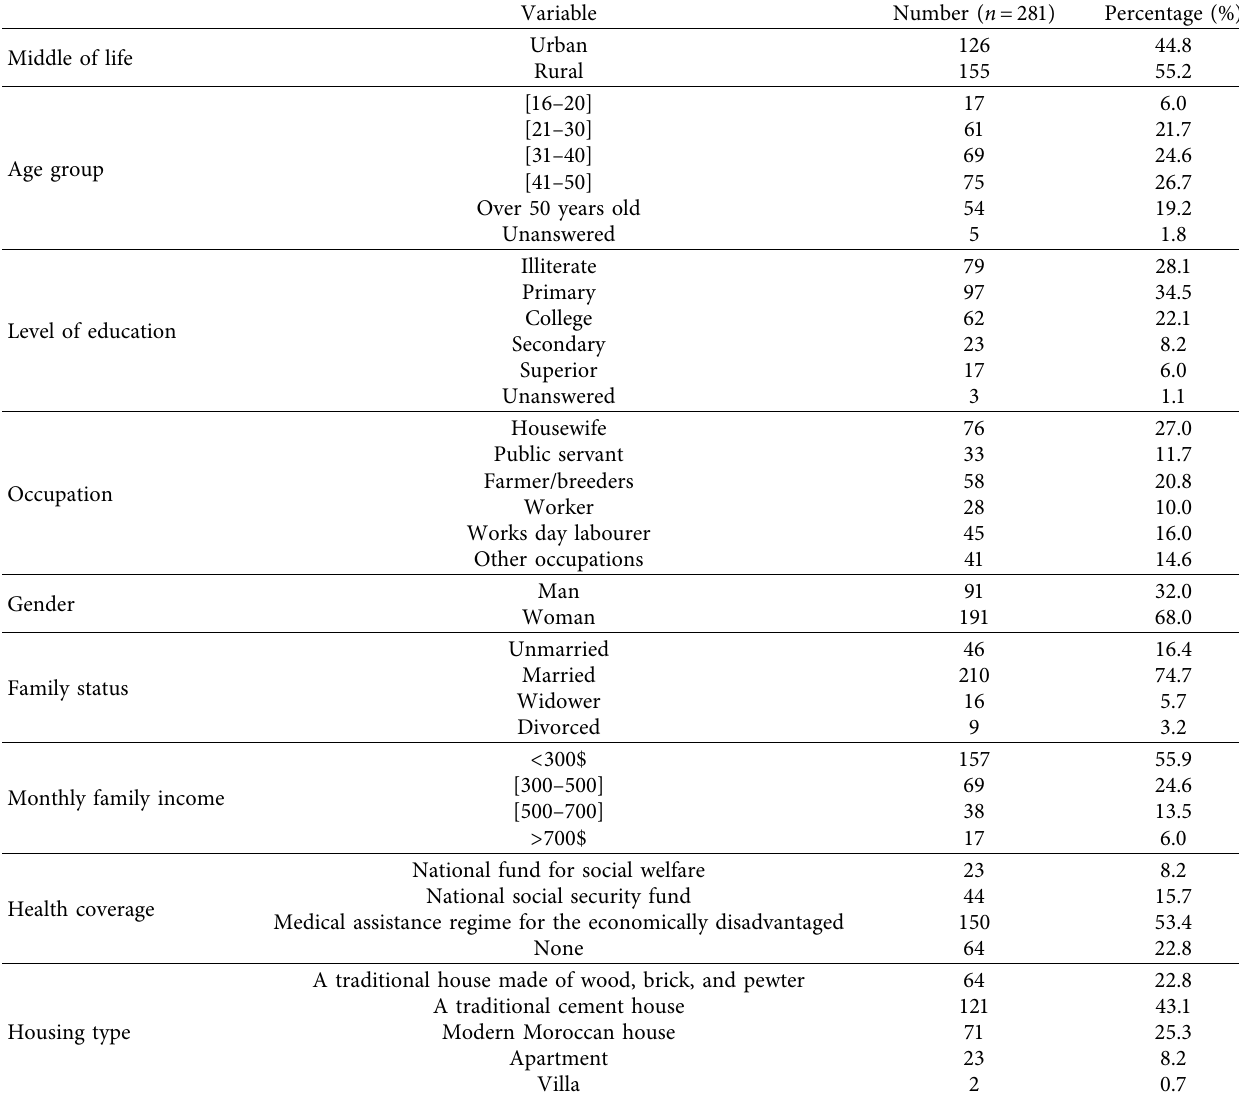
Table 1: Sociodemographic characteristics of